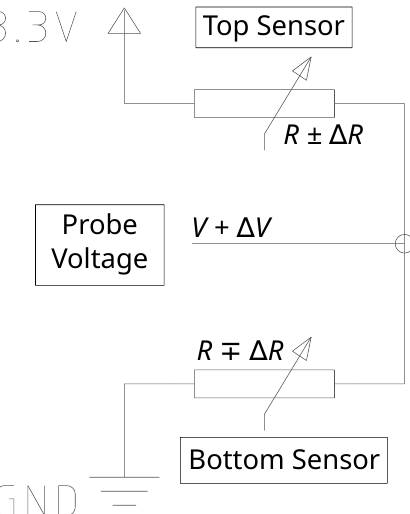
Figure 4. Exploded view illustration of strain gauge units bonding to both sides of sensor board. Stain gauges are placed from above and underneath the sensor body to a location on the surface indicated by the arrows. Holes, for purposes of fastening to the aluminum fixture and for fitting alignment pins between the frame assembly, are rendered in the sensor body for reference.